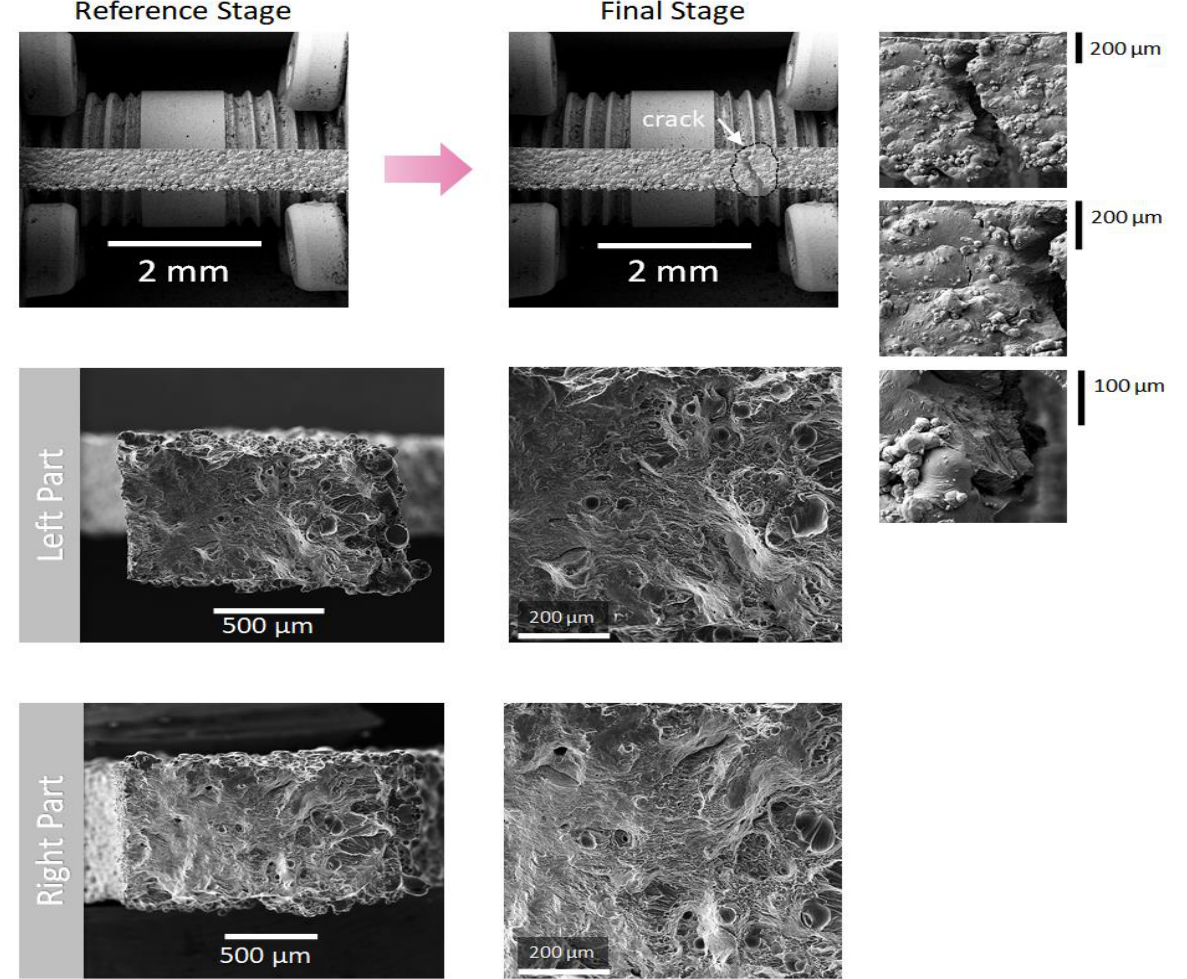
Figure 14. Appearance of fracture surface of an X-Z specimen.